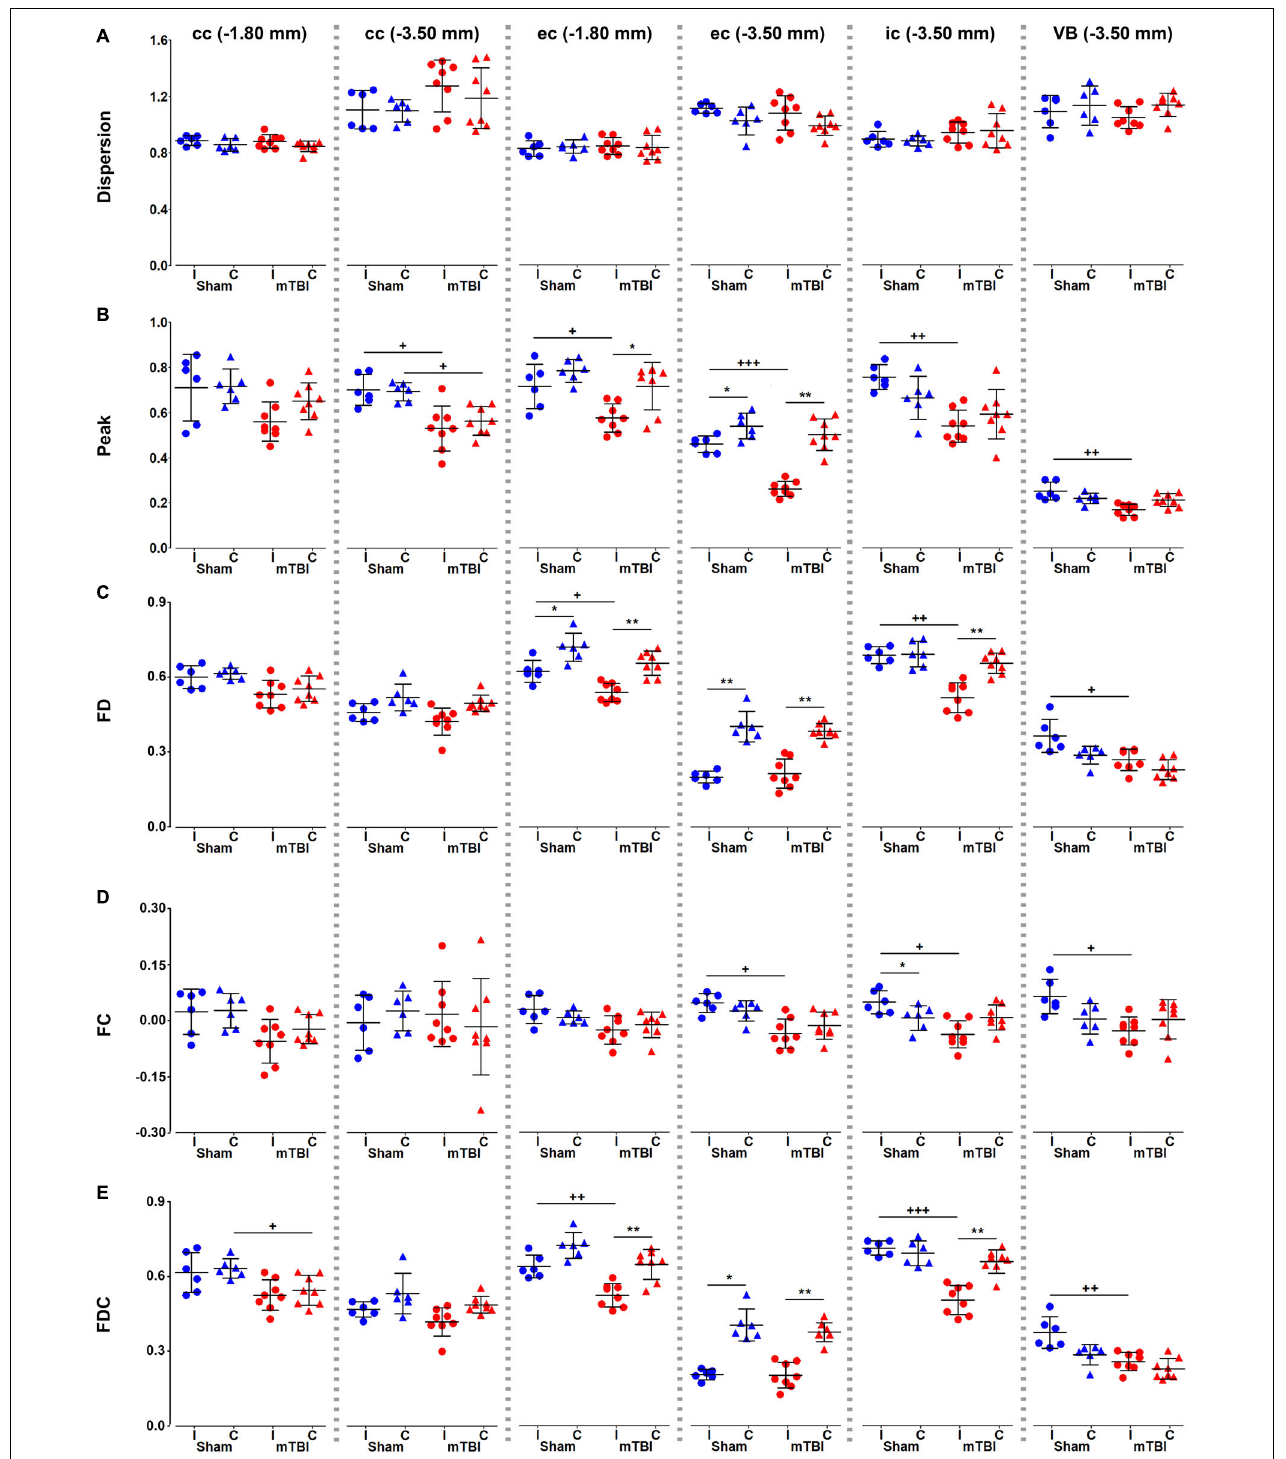
FIGURE 5 | Fixel-based metrics, dispersion (A) , peak FOD amplitudes (B) , FD (C) , FC (D) , and FDC (E) , were analyzed in the corpus callosum and external capsule at –1.80 and –3.50 mm, and the internal capsule and ventrobasal complex at –3.50 mm from bregma. Sham-operated animals are indicated in blue and mTBI in red, while ipsi- and contralateral hemispheres are represented by circles and triangles, respectively. Results are shown as mean and standard deviation, and paired (*) t -test comparing ipsi- and contralateral sides within animals (* q < 0.05, ** q < 0.01) or unpaired (+) t -test comparing the same hemisphere between sham-operated and mTBI rats ( + q < 0.05, ++ q < 0.01, +++ q < 0.001), both FDR-corrected. cc, corpus callosum; ec, external capsule; FC, fiber bundle cross-section; FD, fiber density; FDC, fiber density and fiber bundle cross-section; ic, internal capsule; VB, ventrobasal